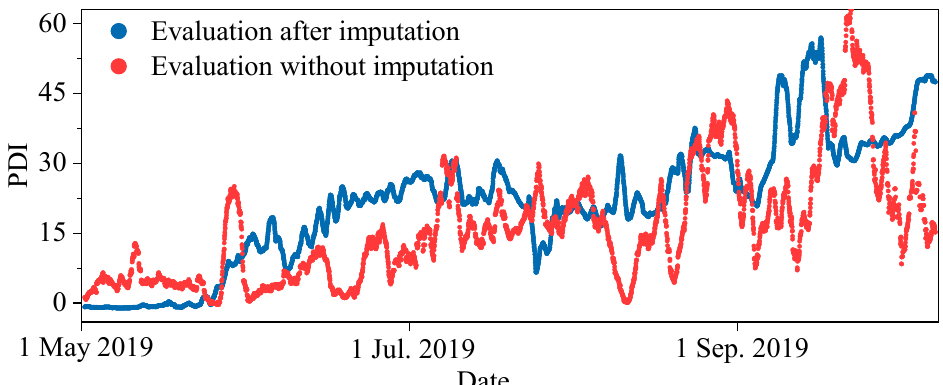
Figure 17. The influence of data imputation on PDI curve.